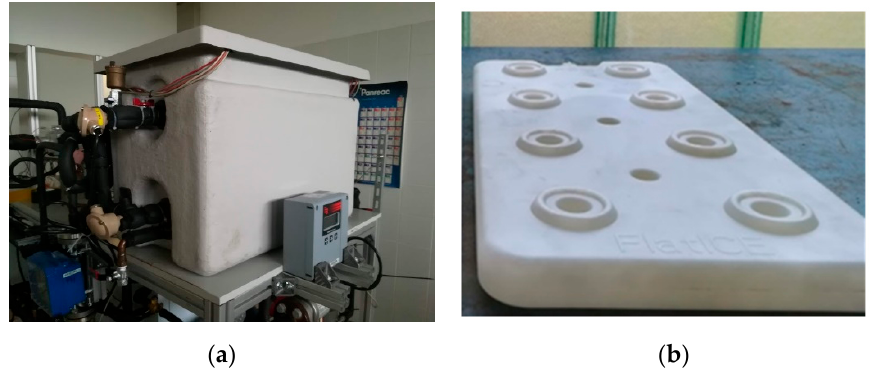
Figure 3. ( a ) PCM storage unit; ( b ) FlatICE PCM slab.